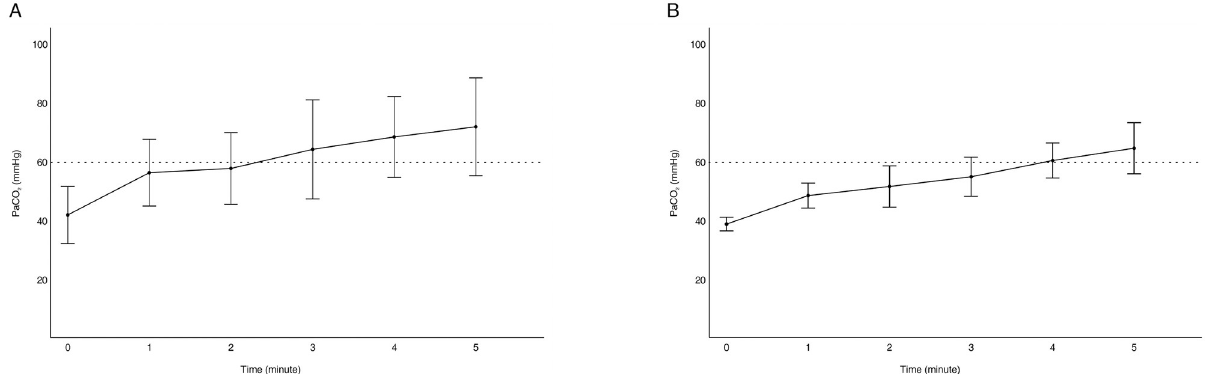
Fig 1. Increase in the partial pressure of carbon dioxide (PaCO 2 ) in the apnea test. (A) At 3 min in the 1 st apnea test, the PaCO 2 level was above 60 mmHg. (B) At 4 min in the 2 nd apnea test, the PaCO 2 level was above 60 mmHg. The apnea test positive criterion is PaCO 2 > 50 mmHg in South Korea, and PaCO 2 > 60 mmHg according to the American Academy of Neurology (AAN) guidelines. The dotted line denotes the apnea test positive criterion according to the AAN guidelines.